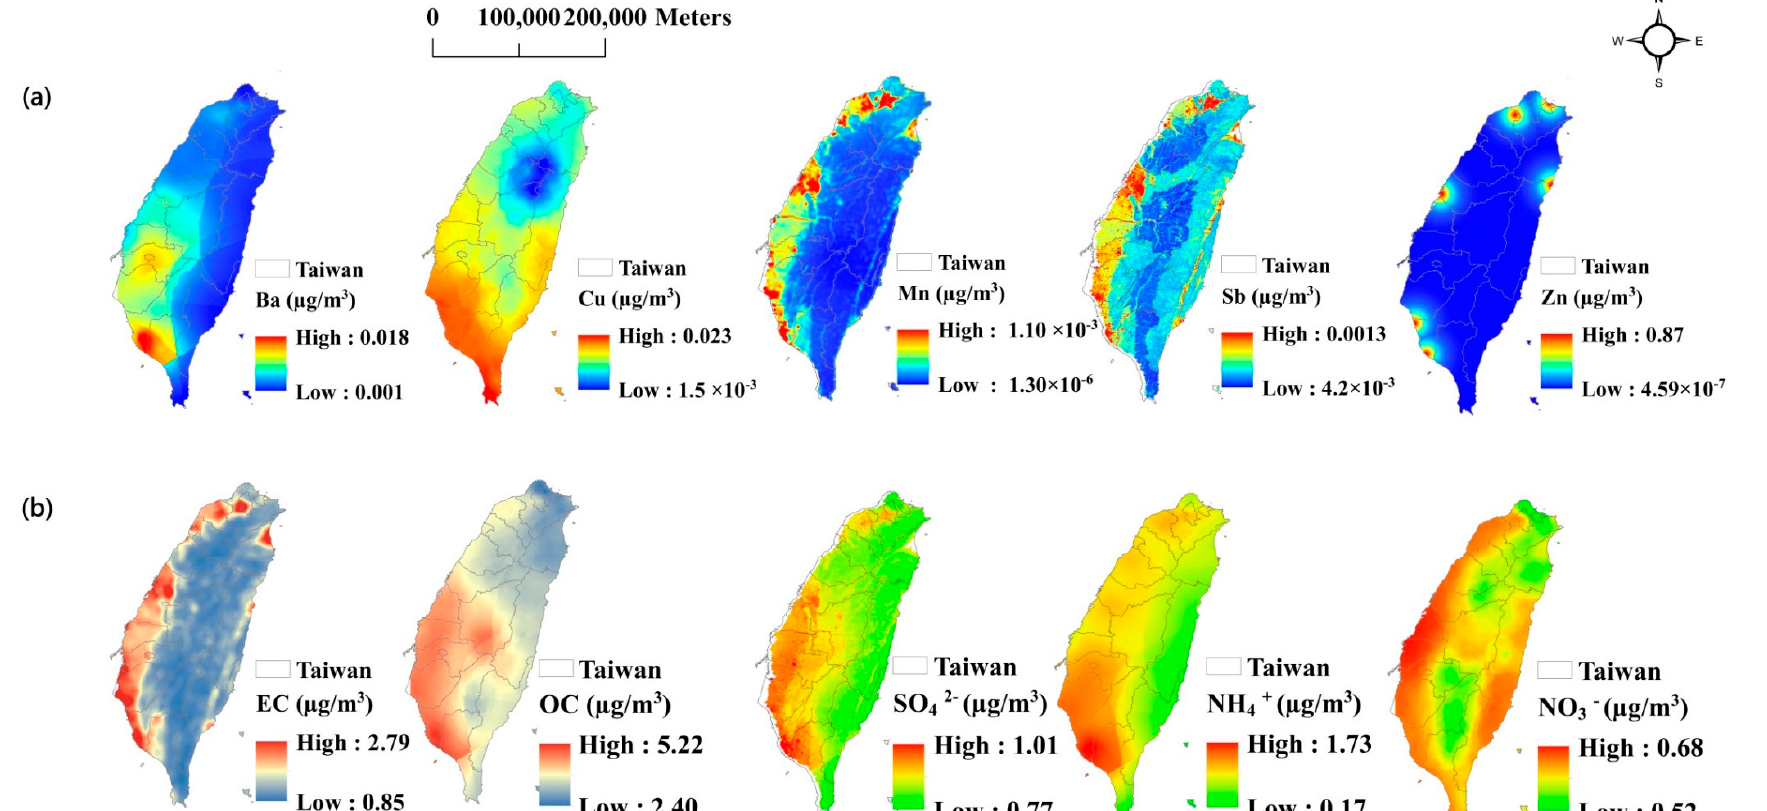
Figure 3. Annual average concentration of PM 2.5 -bound ( a ) nonmetal and ( b ) metal compounds simulated by the developed model.